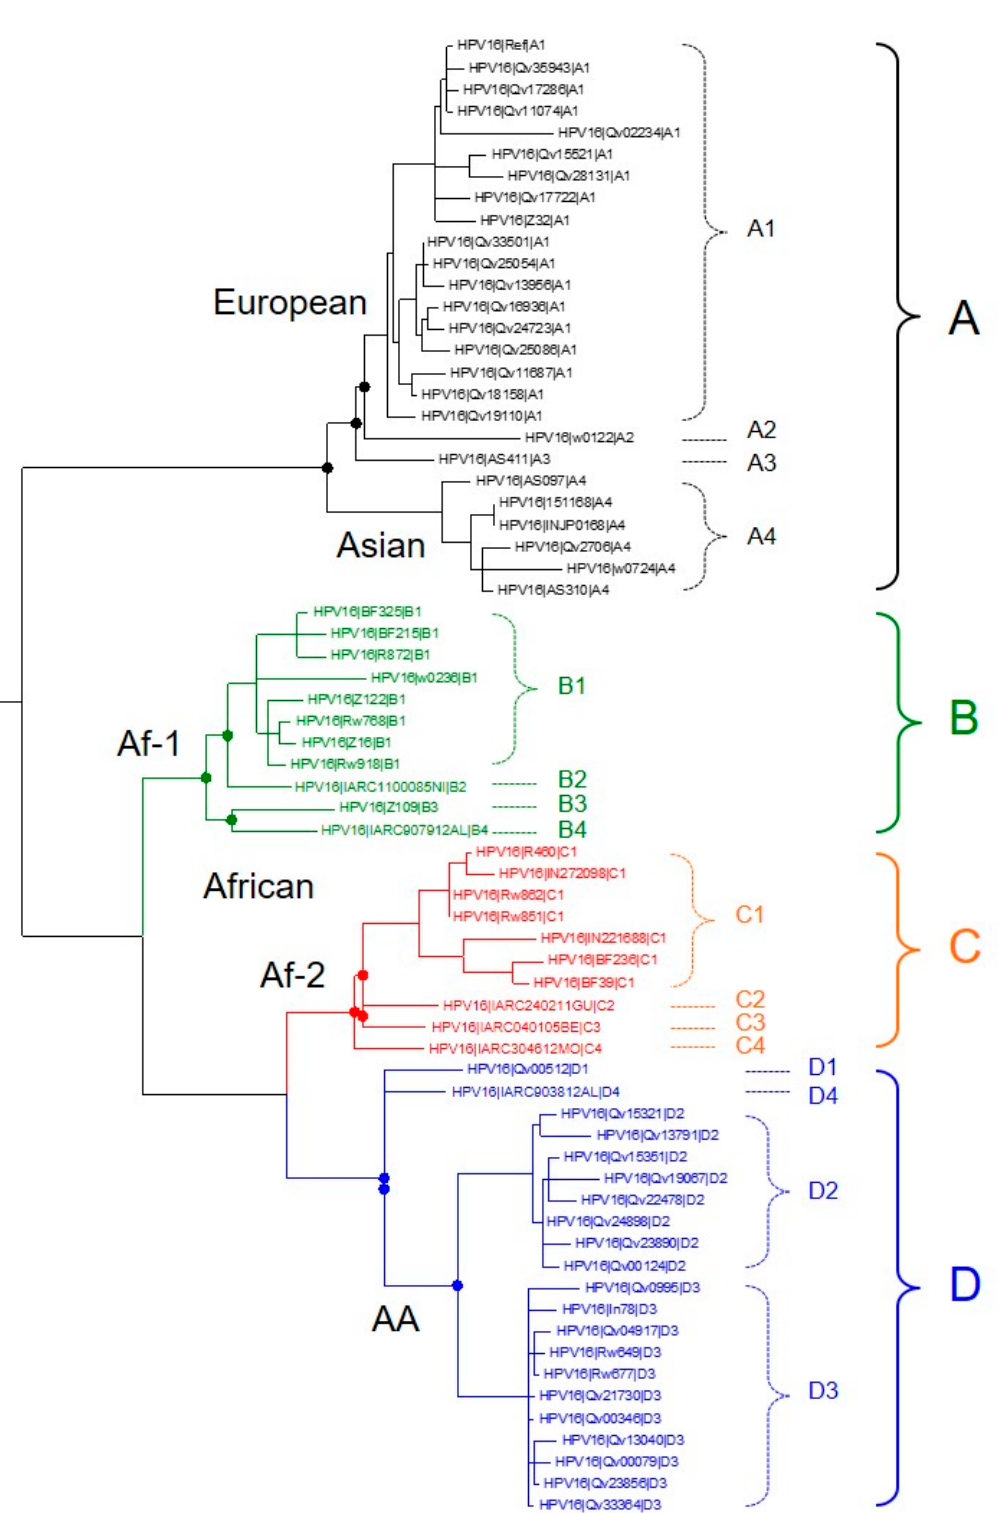
Figure 1. Phylogenetic tree illustrating human papillomavirus 16 (HPV16) lineages (A–D) and sublineage (A1–4, B1–4, C1–4, D1–4) relationships. Colors indicate main lineage branches. A maximum likelihood tree is shown inferred from 66 HPV16 whole-genome sequences, modified from Burk et al., 2013 [15], including additional reference sequence data from Mirabello et al. 2016 [21], 2017 [37]. Af-1, African-1; Af-2, African-2; AA, Asian-American.